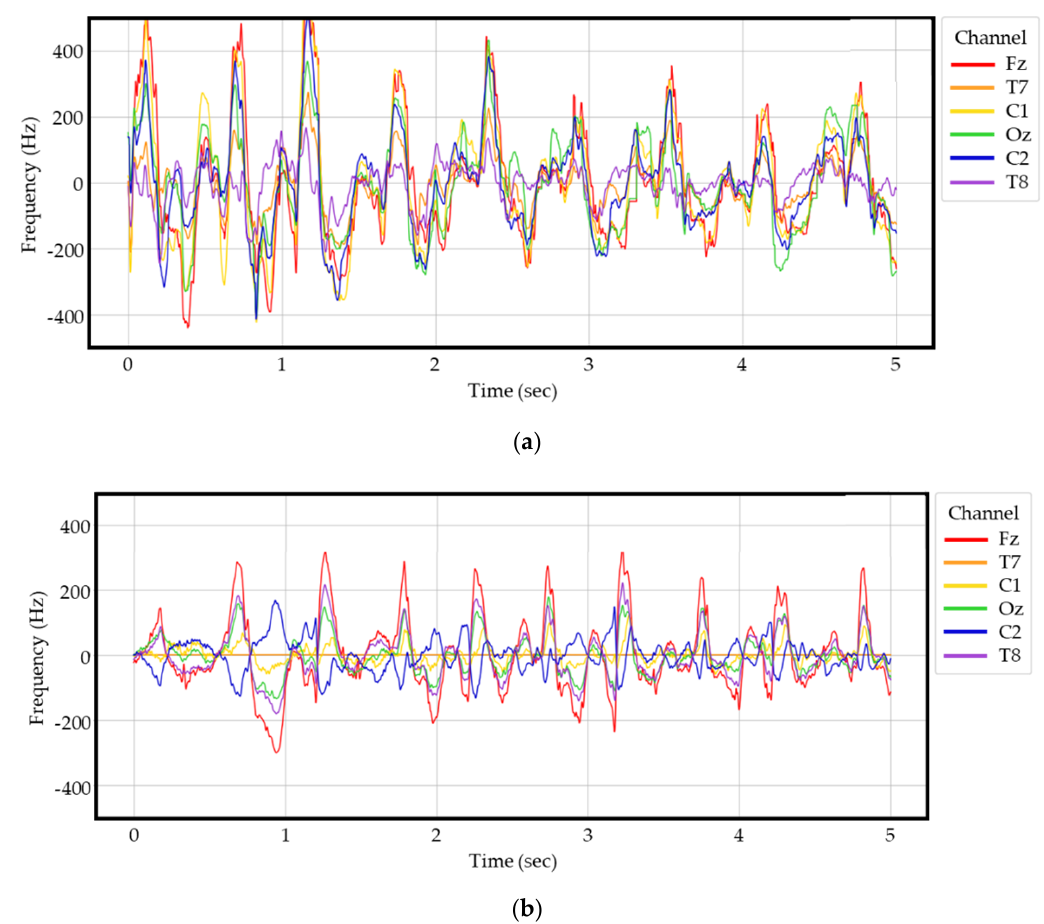
Figure 3. Raw EEG signal samples: ( a ) Raw EEG signals from elderly stroke patients; ( b ) Raw EEG signal samples from control group.